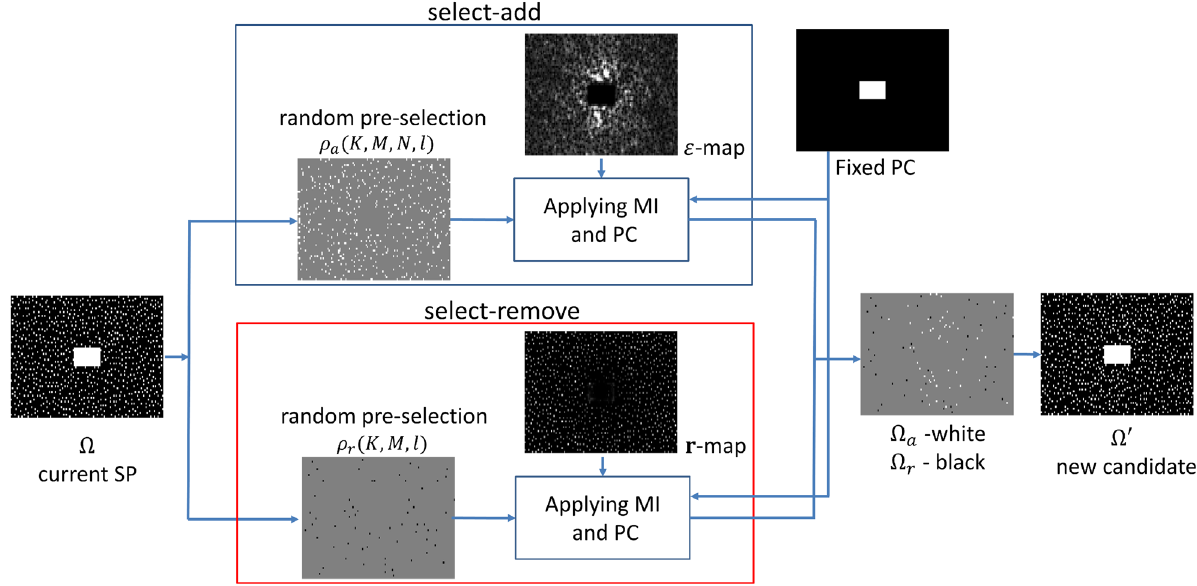
Figure 2. Illustration of the steps used in the functions select-add and select-remove . First, a random pre- selection is done by Bernoulli trials, using probabilities ρ a ( K , M , N , l ) and ρ r ( K , M , l ) . Later selections are made based on the measurement of importance, using the ε -map and the r -map (in which brighter indicates higher values), and the positional constraints (which include identification of the fixed areas). The resulting (cid:31) a is shown in white and (cid:31) r in black in the process of composing (cid:31) ′ . The new candidate (cid:31) ′ is accepted if the cost function is reduced. These steps are repeated at each